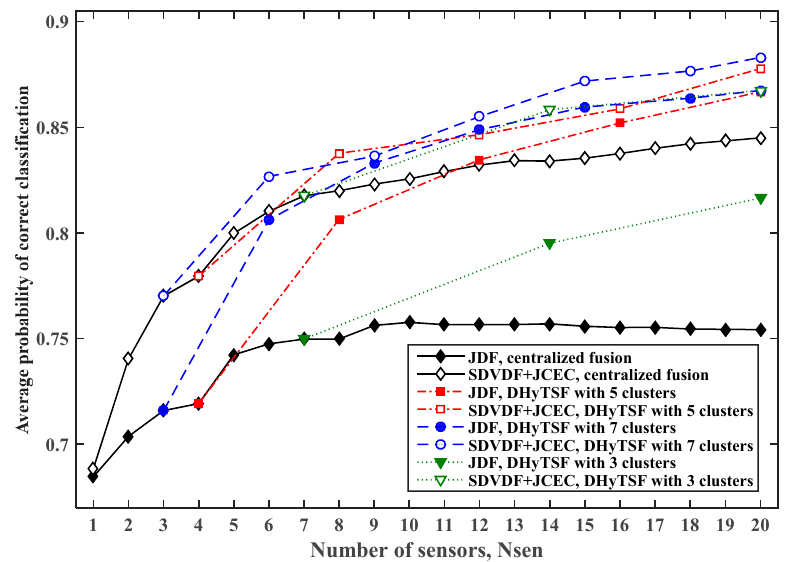
Figure 8. The estimated P CC , avg value for the centralized and distributed cooperative MC in SNS1, for di ff erent number of cluster N CL ∈ { 3,5,7 } , when N S = 500 and L max = 5. The estimated P CC , avg for cooperative MC in SNS2 for network with N CL = 5. clusters of equal size when the mean SNR value in all clusters is 5 dB and 15 dB, and the symbol sequence length is N S = 500 are presented in Figures 9 and 10, for the di ff erent dispersive environments defined with L max = 5 and L max = 10, respectively.